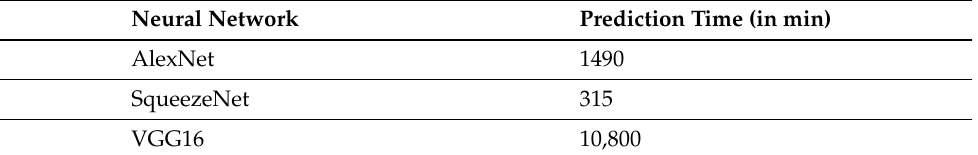
Table 2. Results of the prediction speed testing for the three neural networks: AlexNet, SqueezeNet and VGG16 trained and tested on the training dataset using the computer with 50% GPU and 50% CPU distribution.